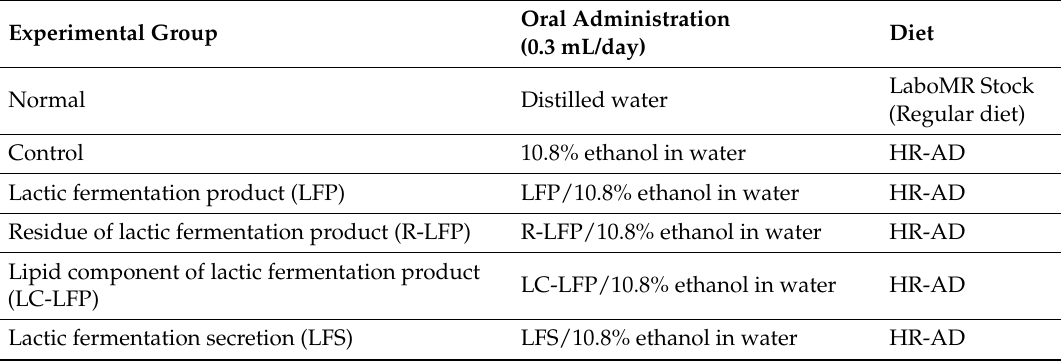
Table 1. Experimental groups in this